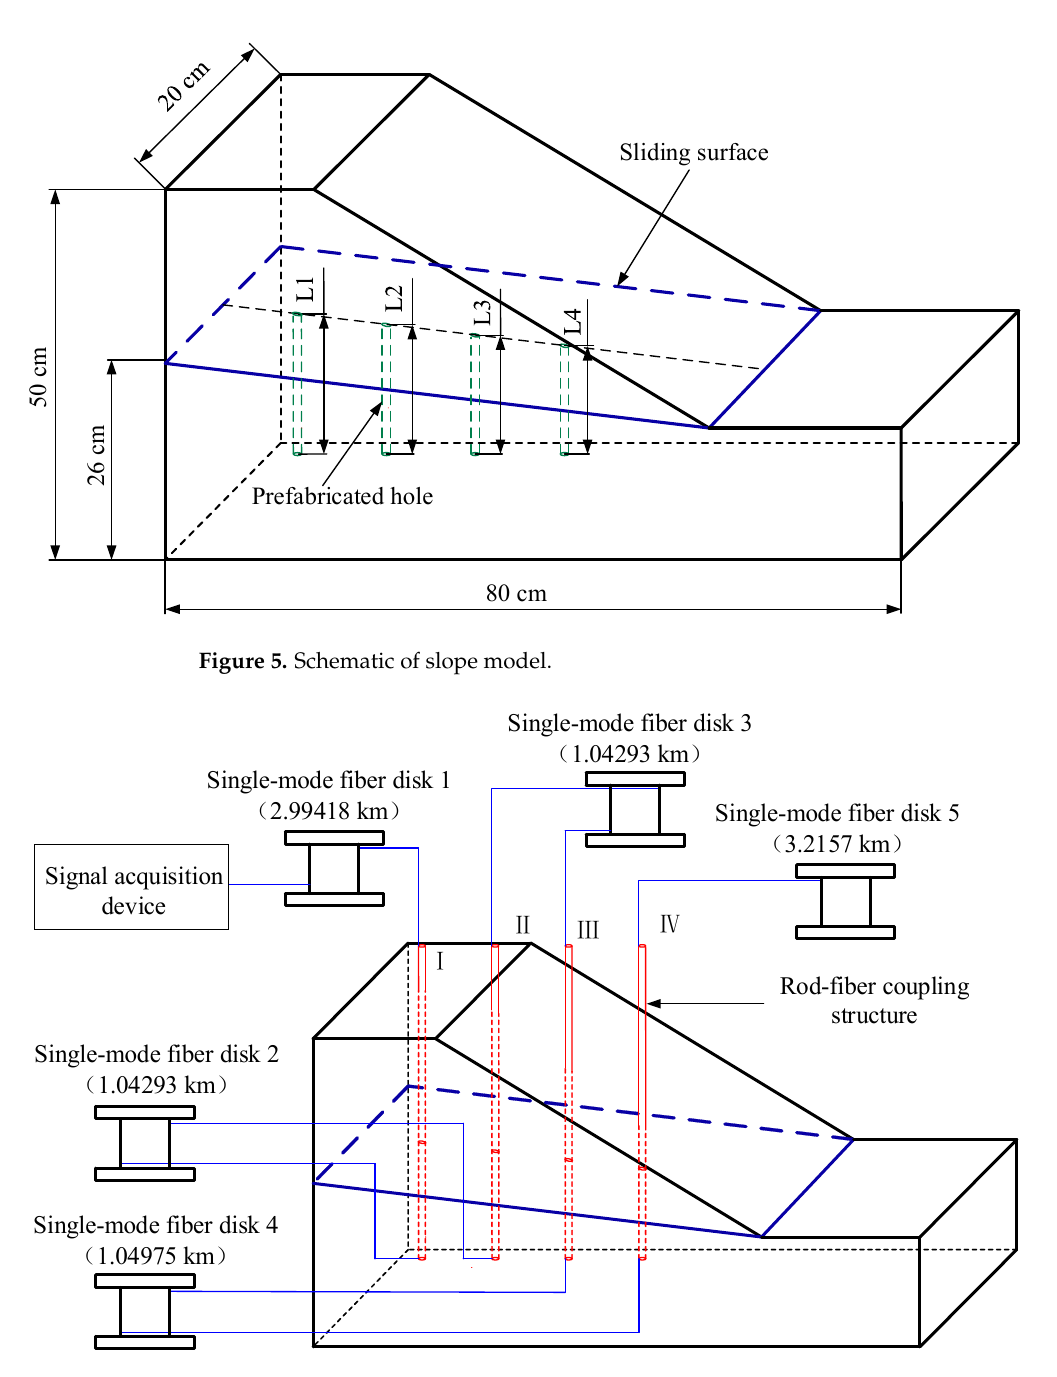
Figure 7. Schematic of slope model experiment. ( a ) rod-fiber coupling structures installation; ( b ) slope model load; ( c ) lateral loading displacement measurement; ( d ) slope toe downslide displace- ment measurement.